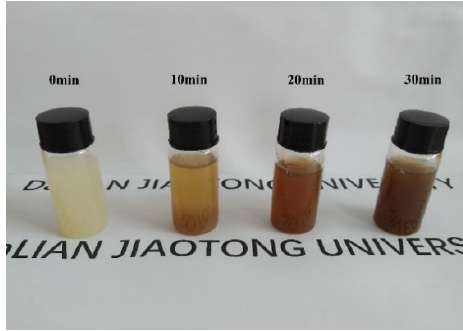
Figure 1. Digital images of the precursor solution with di ff erent stirring